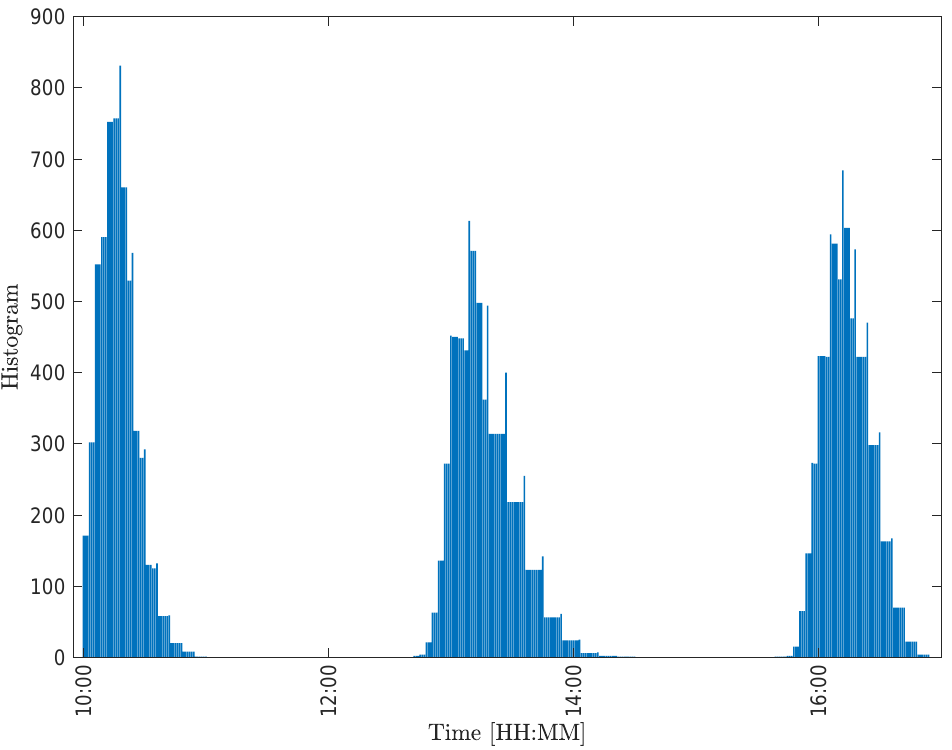
Figure 10. Air conditioner usage schedule.